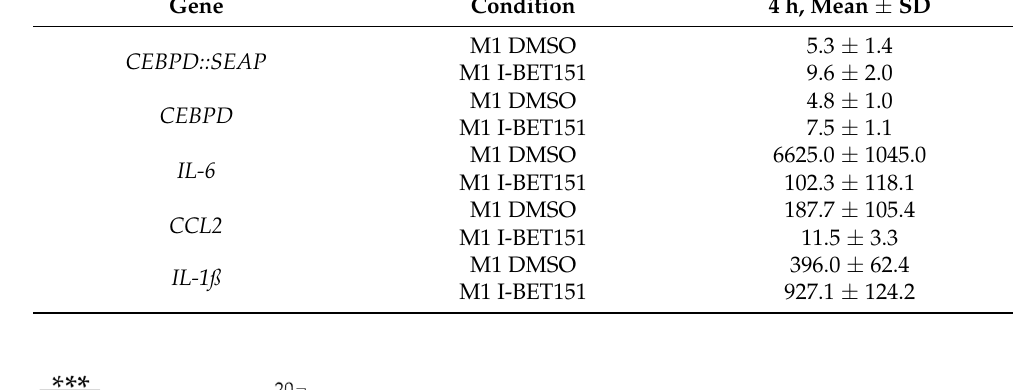
Table 2. Fold change (mean ± SD) for mRNA expression in I-BET151-pre-treated target cells com- pared to M0 controls ( compare Figure 4).